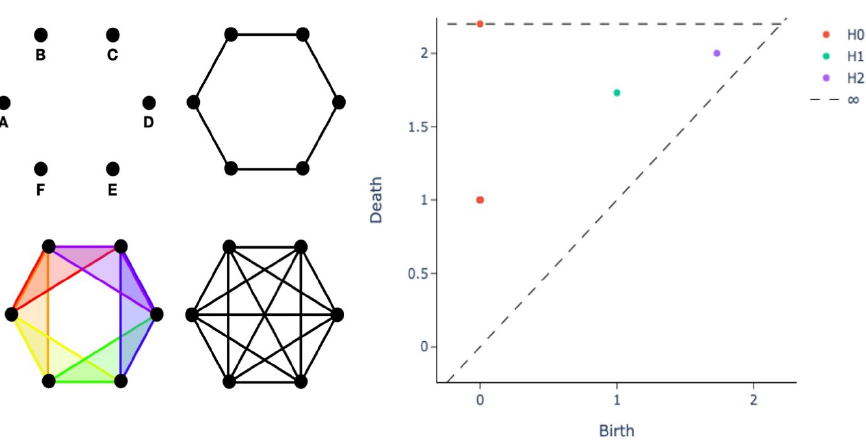
Figure 2. Persistence diagram ( right panel ) for different vietoris rips complexes on equilateral hexagons with side length of 1 ( left panel ). In the left panel, we display the four different categories of vietoris rips complexes generated by 6 points, forming the vertices of a regular hexagon of side length 1 in the Euclidean plane: 0-simplices ( top left ), 0- and 1-simplices ( top right ), 0-, 1- and 2-simplices ( bottom left ) and complexes including simplices of degree higher than 2 ( bottom right ). In the right panel, each point in the scatterplot represents a specific topological feature of the dataset, where the axes denote the values of the distance for which topological features appear (“birth” on the x axis) and vanish (“death” on the y